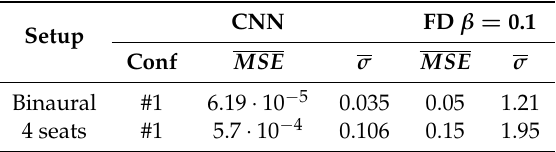
Table 4. Audio equalization results for the Jeep Renegade with binaural microphones and four microphones (one per seat). The FIR order is